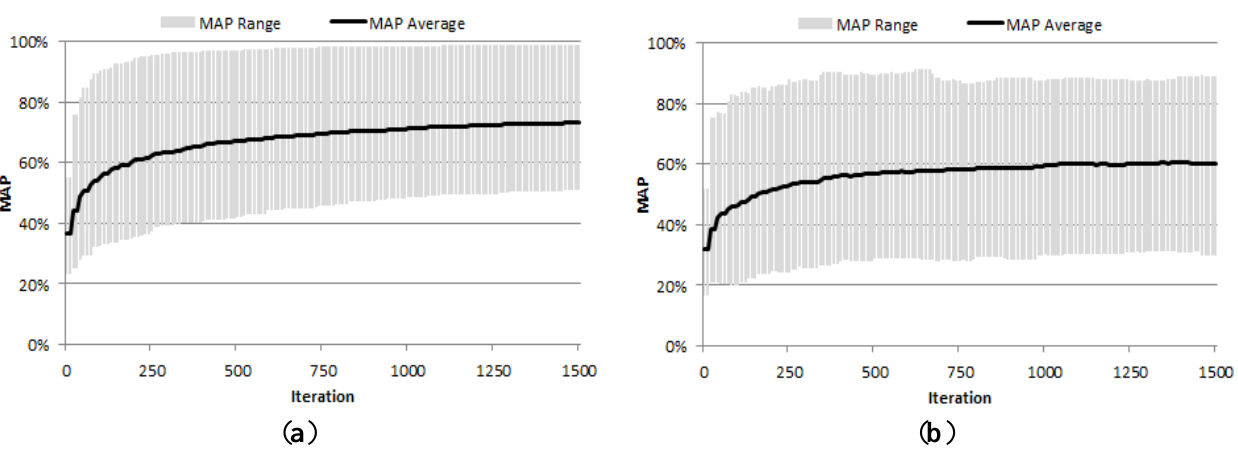
ranking images from the WROC data set using the Associative & SFFS.